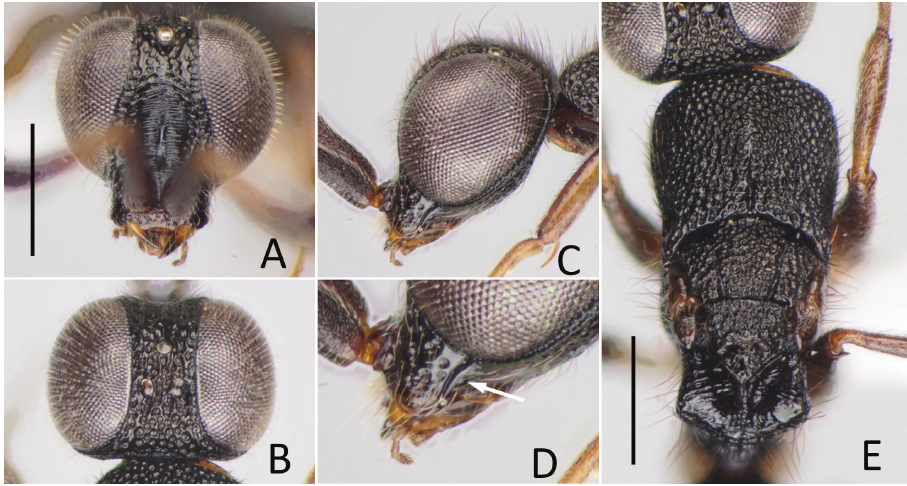
Figure 10. Okinawasega eguchii Terayama ♀ A head in frontal view B ditto, dorsal view C ditto, lateral view D ditto, malar space (arrow indicates malar sulcus) E mesosoma. Scale bars: 0.5